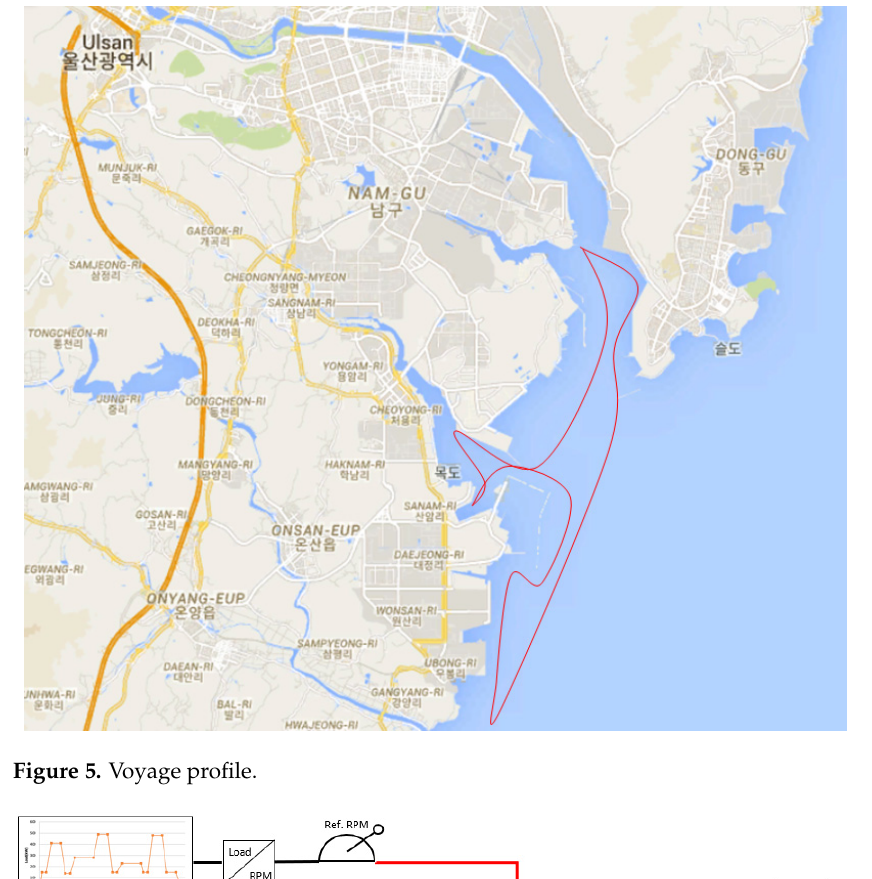
Figure 5. Voyage profile.